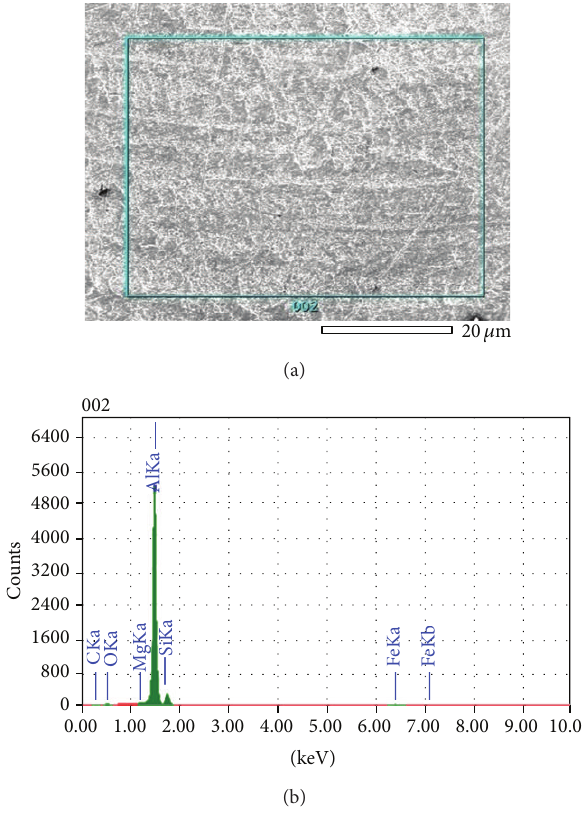
Figure 15: (a) MML on the worn surface of the Al-7.5wt.% Gr composite. (b) EDS spectrum of MML of the Al-7.5 wt.% Gr composite when tested at 49N, 2m/s.